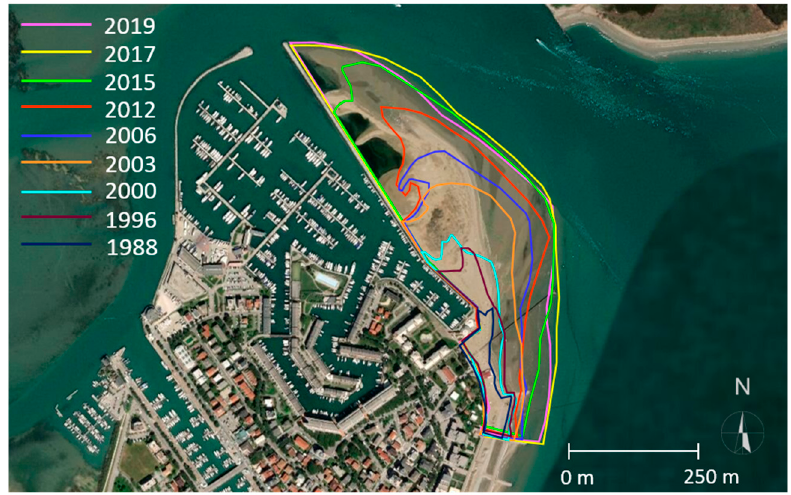
Figure 4. Historical reconstruction of the sand deposit from 1988 to 2019: border lines of the progressive growth.